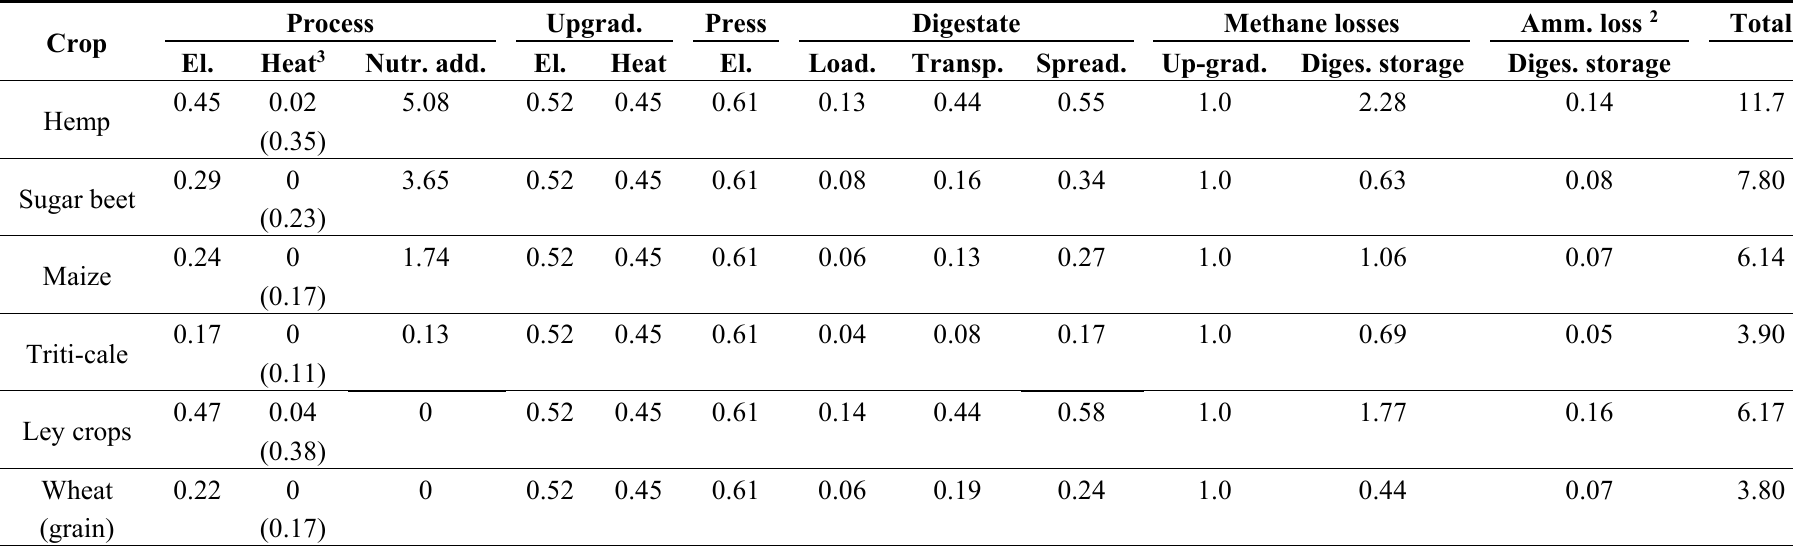
Table 4. Emissions of greenhouse gases from the conversion system of energy crops into upgraded and pressurised biogas,